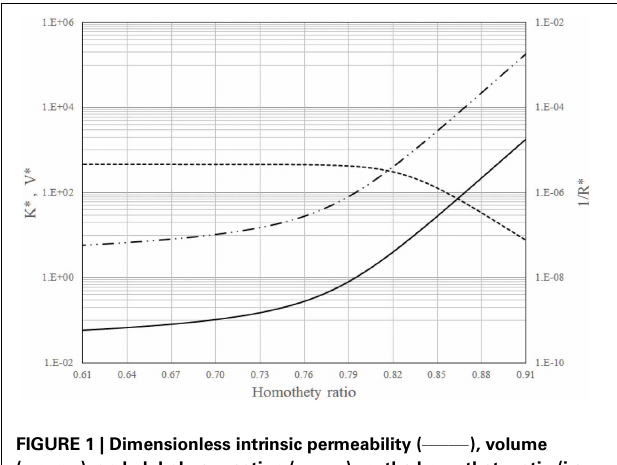
FIGURE 1 | Dimensionless intrinsic permeability ( _______ ), volume ( __ .. __ .. __ ), and global permeation ( __ __ __ ) vs. the homothety ratio (i.e., reduction factor between parent and daughters vessels): 23 generations of branches in the dendritic